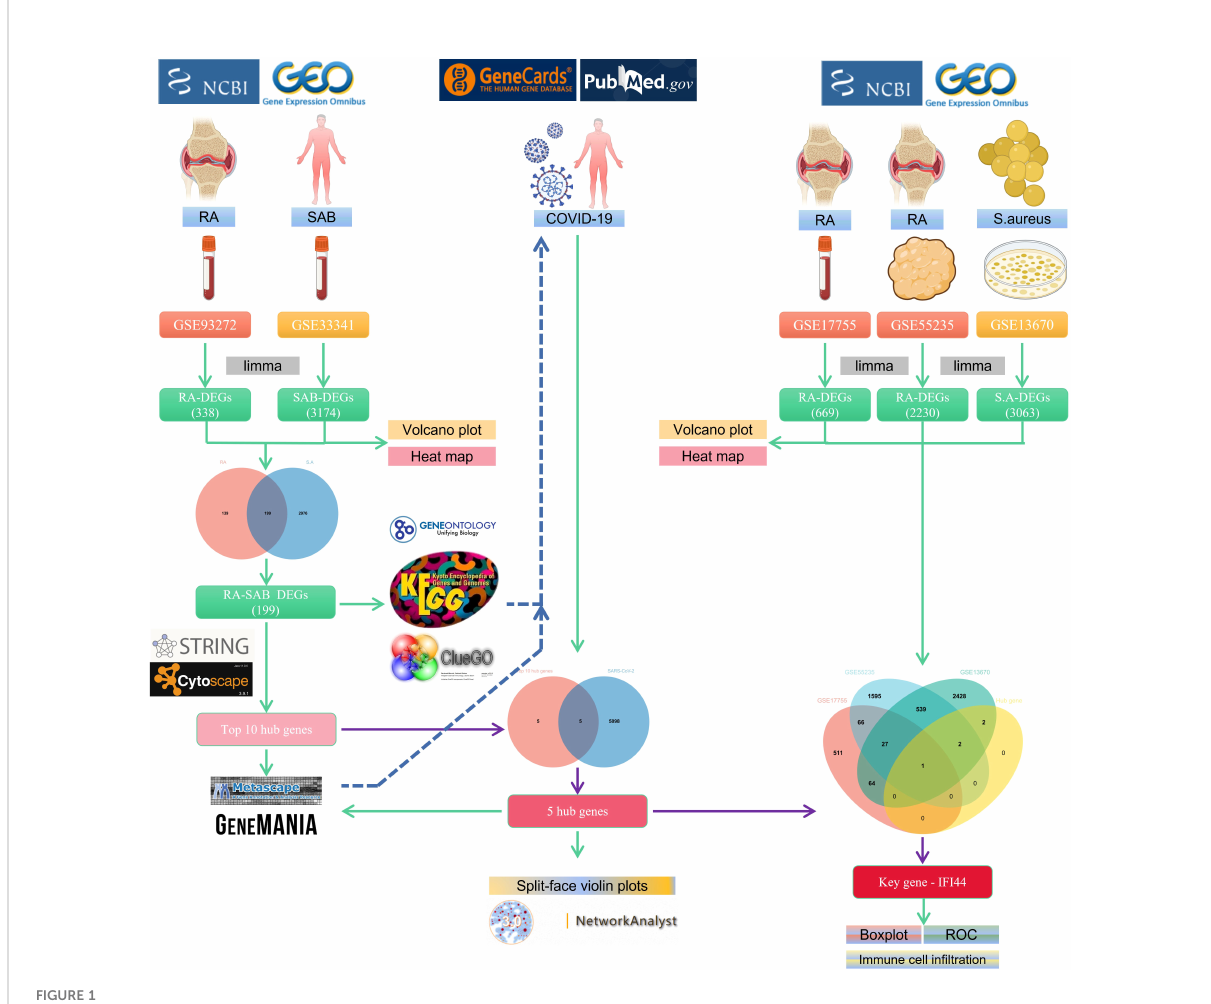
FIGURE 1 The schematic block diagram of the entire work fl ow of this